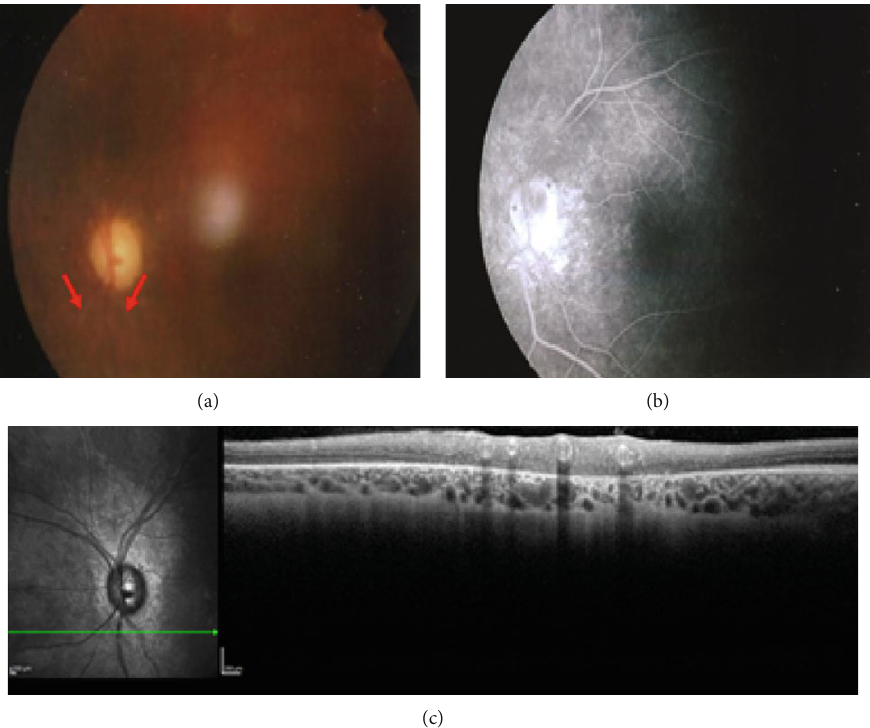
Figure 3: Case 3. (a) Sheathed aspect of vessels emerged from the lower bound of the optic nerve head (red arrows), blurred image due to optical opacities. (b) Late stages of the angiogram demonstrate normal fl uorescence of the vascular tree. Staining was noted on the inferotemporal border of the optic nerve related to chorioretinal atrophy. (c) SD-OCT scan demonstrated typical internal hourglass con fi guration and a highly re fl ective vessel wall in both arterioles and